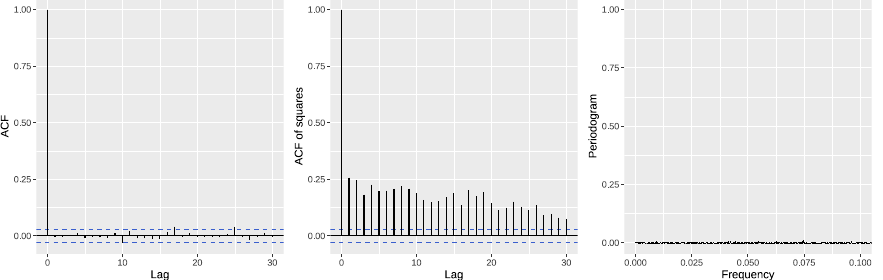
Figure 9. Autocorrelation functions and periodogram of the ARFIMA ( 4,0.1398,4 ) residuals.